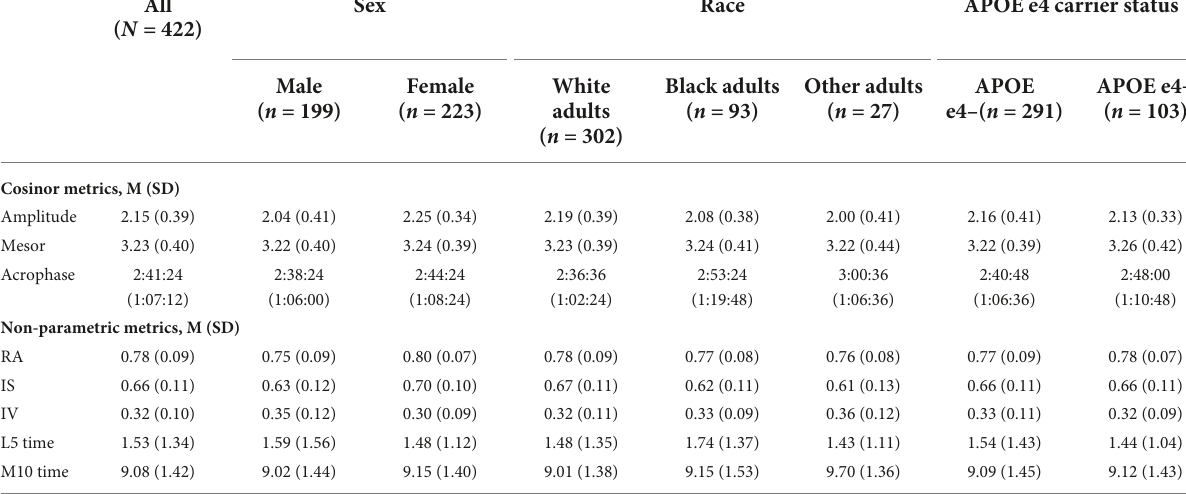
TABLE 4 Baseline CRAR characteristics for the whole sample and stratified by sex, race, and APOE e4 status. All ( N = 422)